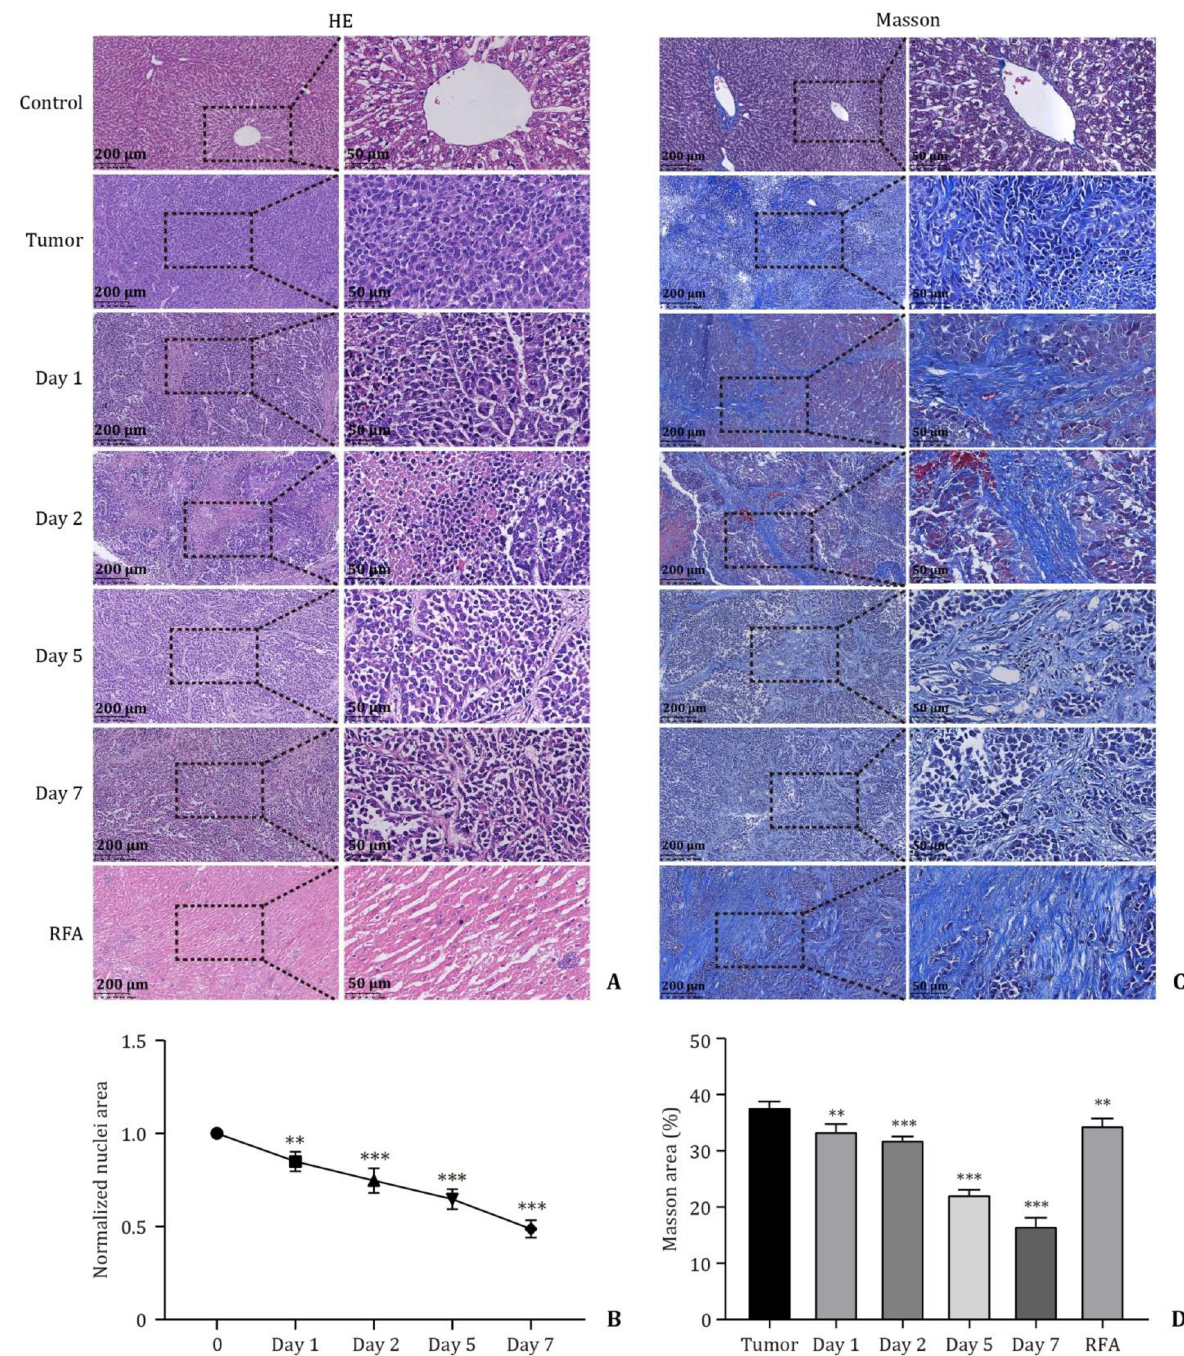
Fig 5. HE staining and Masson staining images and analysis of tumor tissue after ablation. A and C : HE and Masson staining were performed on the tissues at days 1, 2, 5 and 7 after nsPEF ablation and 5 days after RFA ( n = 6). B : The percentage of nuclear area was calculated in the total high magnification field at different time points and groups (Days 1, 2, 5, and 7 were compared with the hypothesis at 0). D : The IOD percentage of the Masson staining area was calculated at different time points and groups (Days 1, 2, 5, and 7 and RFA groups were each compared with the tumor group). Data are expressed as the mean ± SD. �� P < 0.01; ��� P < 0.001. nsPEFs: nanosecond pulsed electric fields; RFA: radiofrequency ablation; IOD: integrated optical